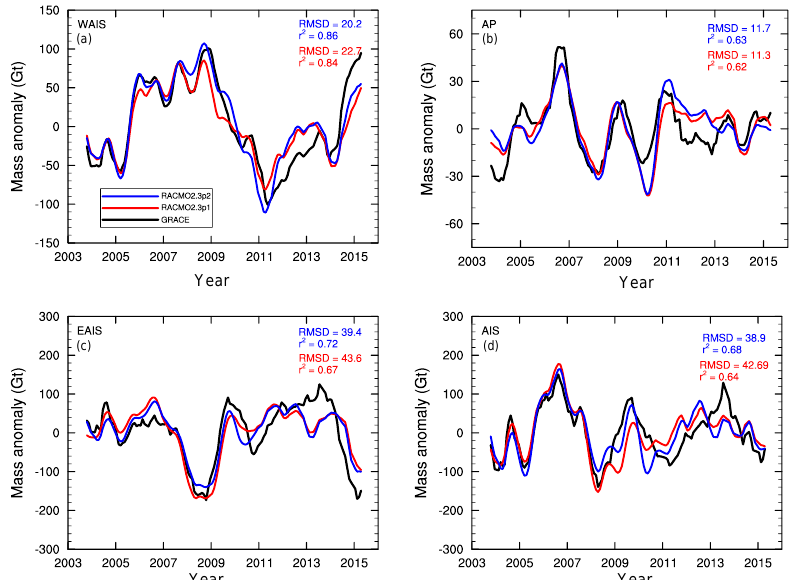
Figure 9. Detrended and decelerated average (for details see text) SMB anomalies of RACMO2.3p2 (blue), RACMO2.3p1(red) and GRACE (black) release RL05 for West Antarctica (a) , the Antarctic Peninsula (b) , East Antarctica (c) and the whole Antarctic ice sheet (AIS, d ). Shown are root mean square deviation (RMSD) and correlation ( r 2 ).